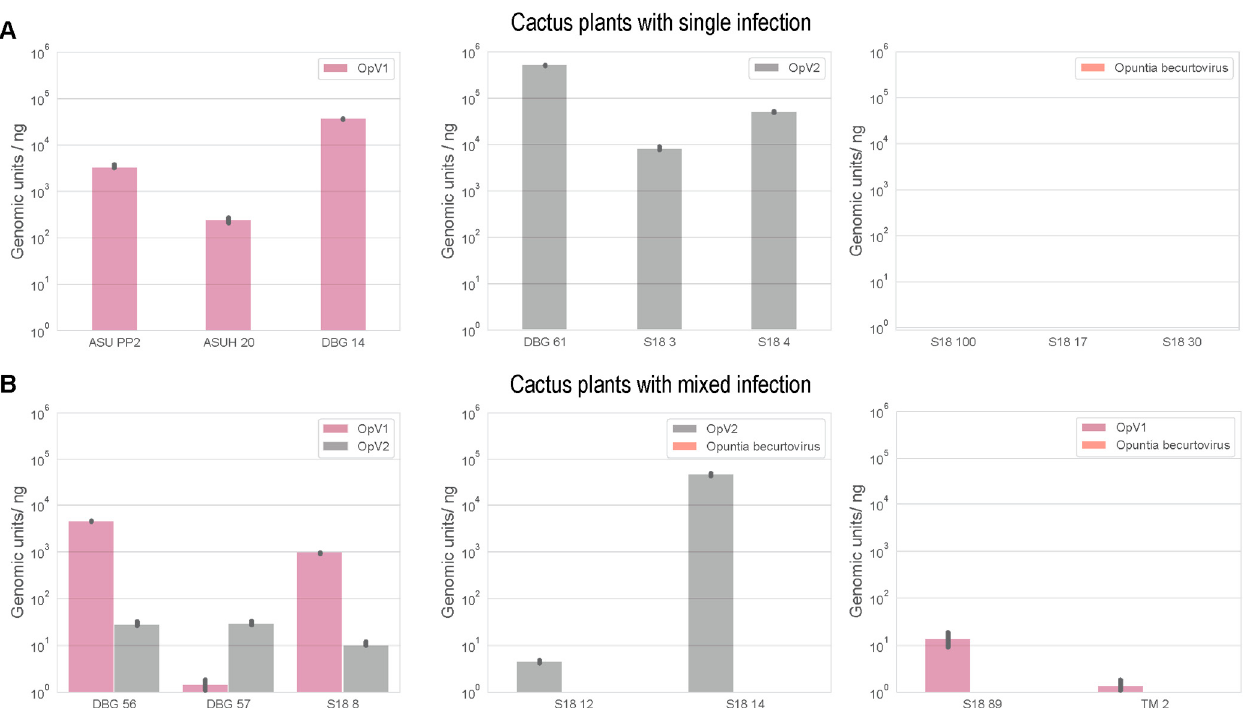
Figure 6. Bar graph of the viral loads (genomic units/ng of total DNA) determined by real-time quantitative PCR for the Opuntia virus 1 (OpV1), Opuntia virus 2 (OpV2), and Opuntia becurtovirus in a subset of cactus samples collected in this study. The graphs show ( A ) the group of single-infected cacti and ( B ) the cactus samples that presented mixed infection with standard deviation for the triplicate reactions. The Opuntia becurtovirus was the only virus that did not present detectable levels of genomic units.